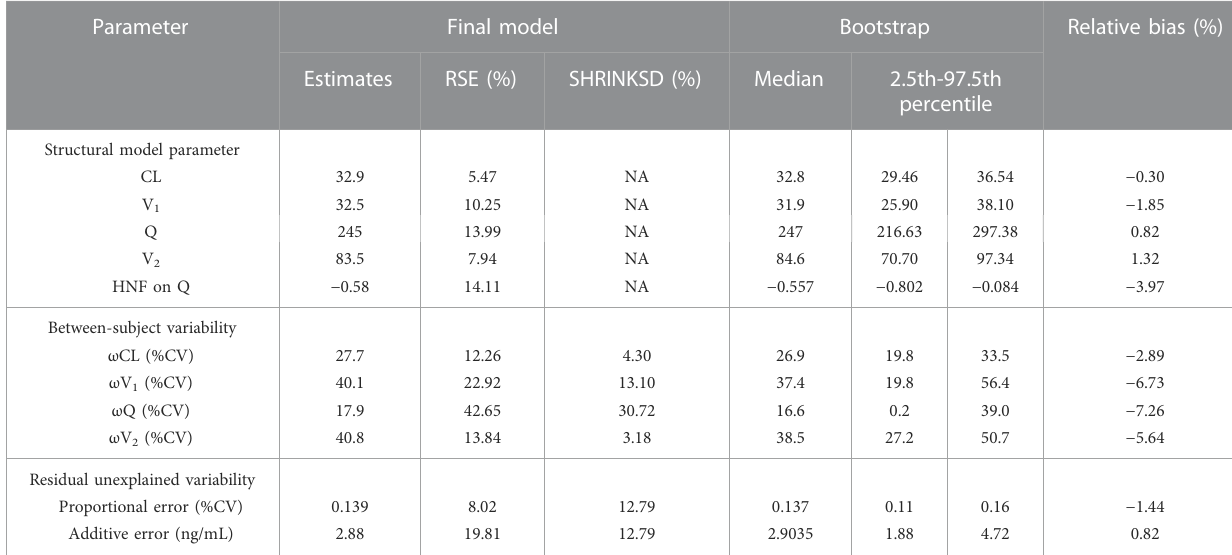
TABLE 4 Population pharmacokinetic parameter estimates of nalbuphine in the fi nal model and bootstrap